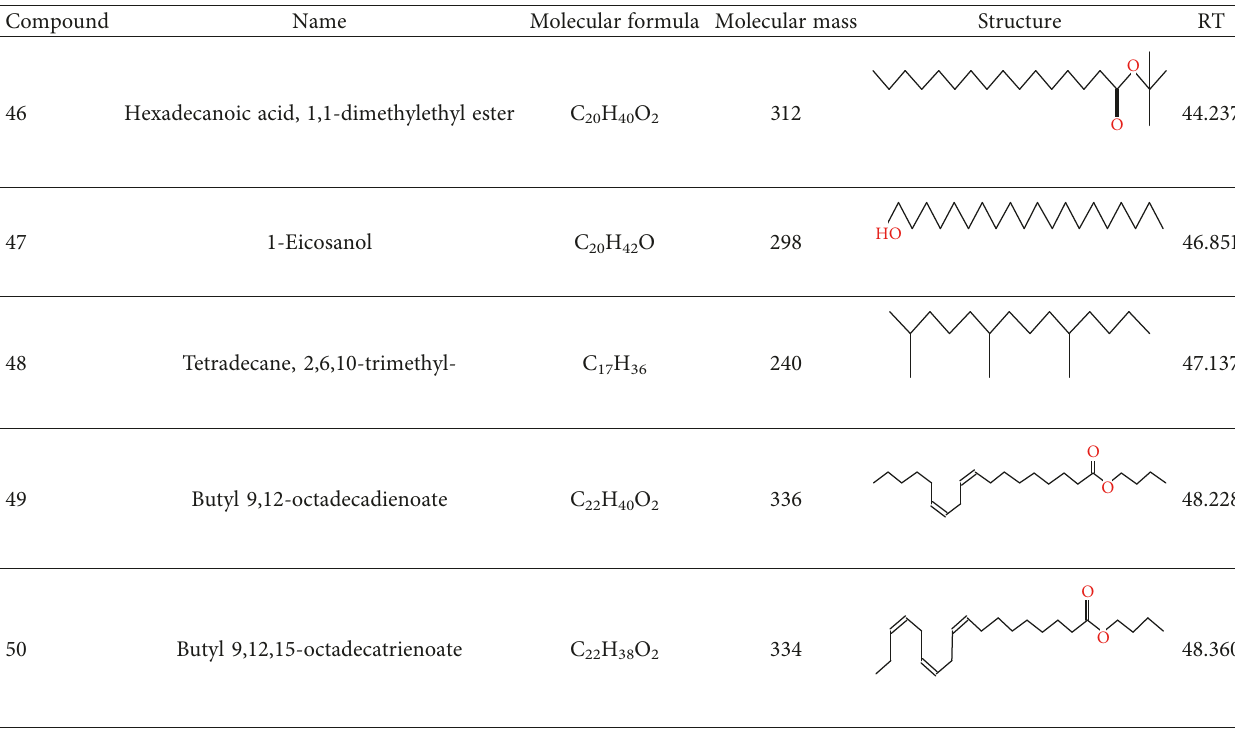
Table 11: Molecular formula, molecular mass, structure, and RT of compounds 46–50 of whole plant n -hexane fraction of Achillea wilhelmsii (WHFAW).